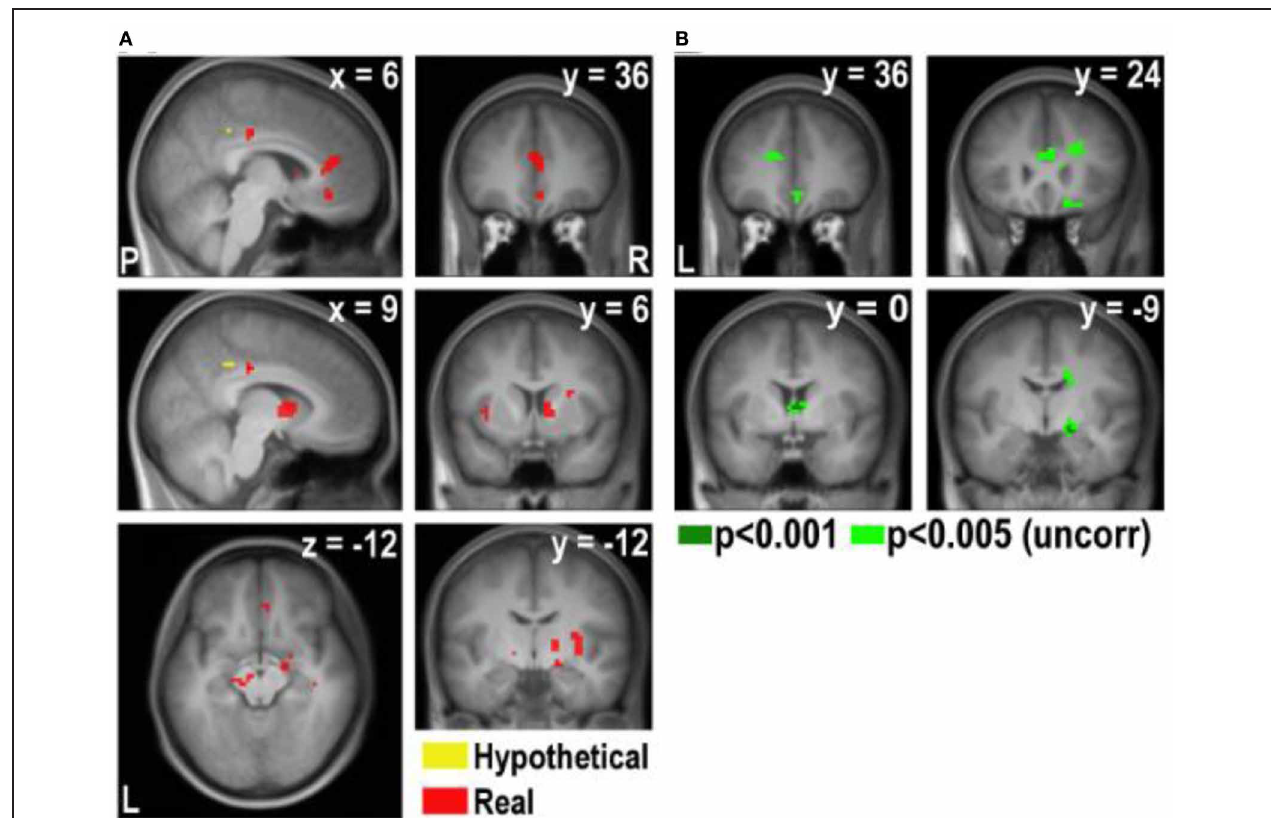
FIGURE A4 | Areas exhibiting higher correlation with disgust rating in real and hypothetical trials (note that a lower disgust rating indicates a higher level of disgust). (A) Overlay of the hypothetical × disgust and real × disgust contrasts, p < 0 . 001 (uncorrected). (B) [real × disgust - hypothetical × disgust] contrast.